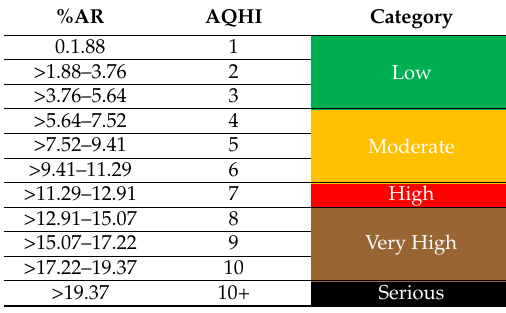
Table 3. “Added health risk” (%AR) factor levels for calculating the Air Quality Health Index (AQHI) and categories adapted from Wong et al. (2012). Each color conforms to a given